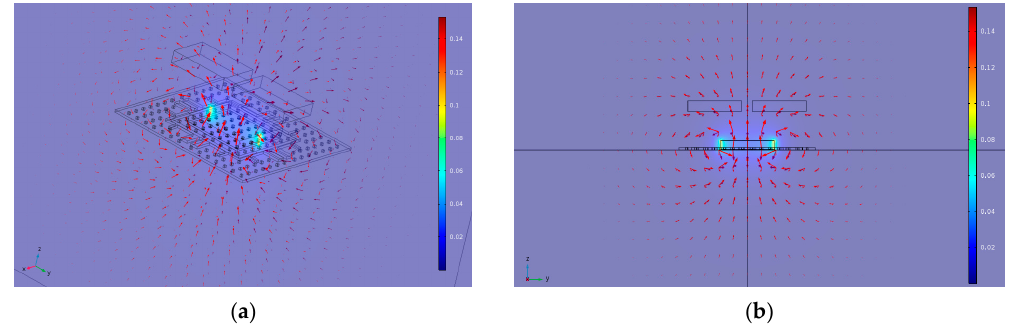
Figure 5. Finite element simulation of magnetic field distribution for permanent magnetic film. ( a ) Three dimensional magnetic field distribution; ( b ) Planar magnetic field distribution in the middle section along the y-direction.